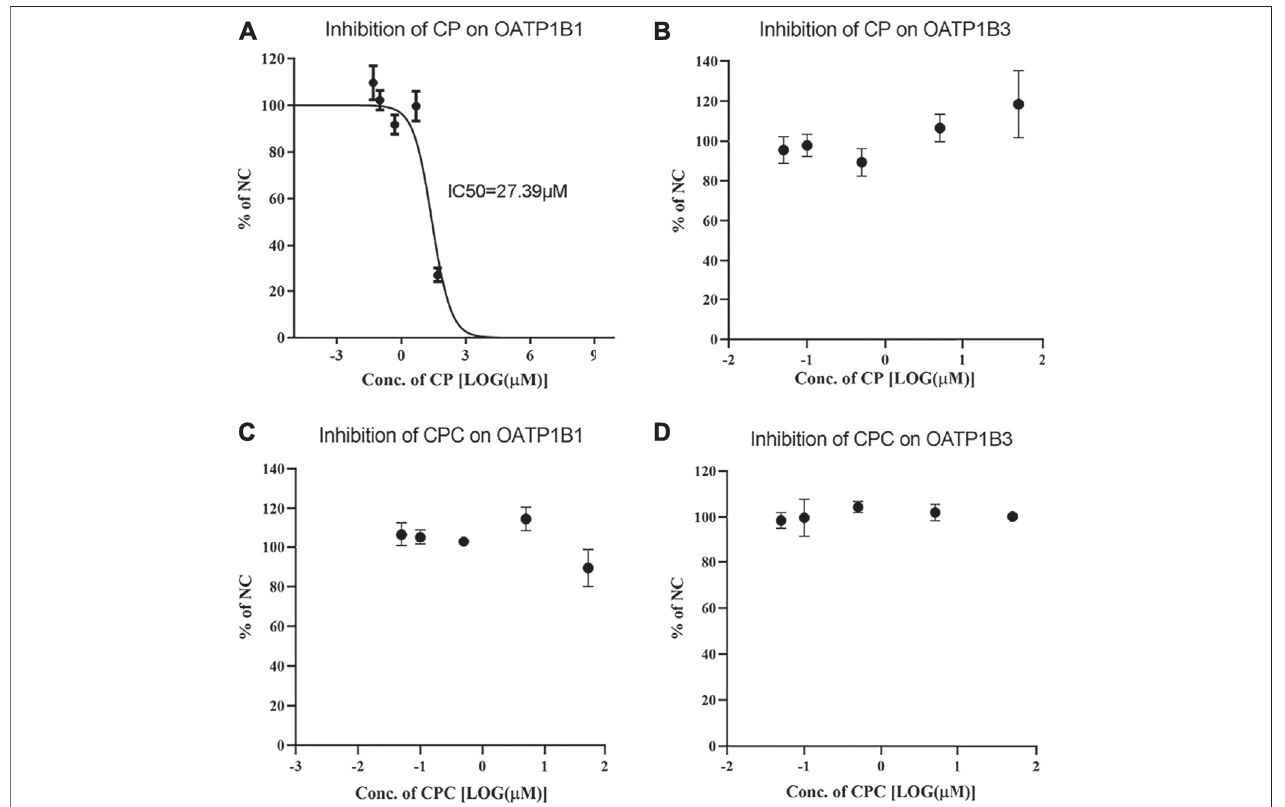
FIGURE 1 | Inhibition potency of CP and CPC on OATP1B1- or OATP1B3-mediated RSV transport. The mean relative uptake activity (% of NC) of RSV by OATP1B1 (A and C) , OATP1B3 (B and D) with varying concentrations of CP or CPC. Data are presented as the mean ± S.D. ( n (cid:2) 3).